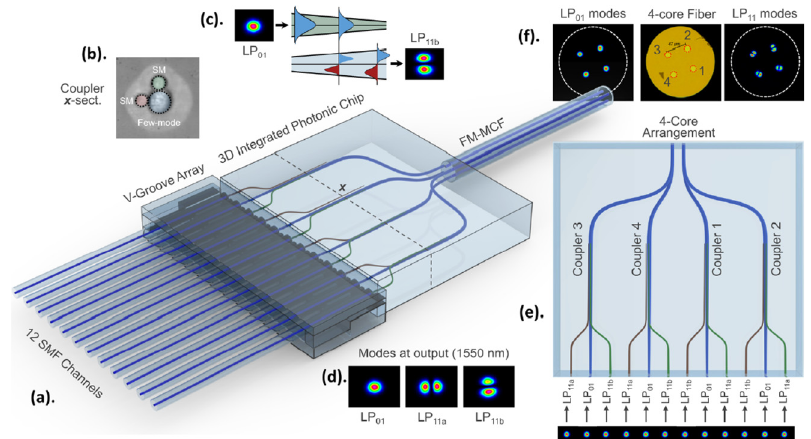
Figure 26: (a) 3D schematic of FM-MCF multiplexer. (b) Microscope image of cross section of few-mode coupler; (c) the adia- batic mode evolution in few-mode coupler; (d) infrared images of LP 01 , LP 11 a , and LP 11 b modes of one core. (e) Top view of multi- plexer; (f) cross section of a 3-mode 4-core fi ber and modes excited in each core [268]. FM-MCF, few-mode multicore fi